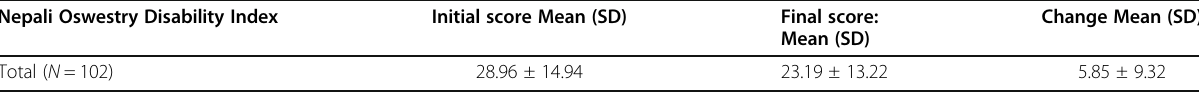
Table 2 NODI Score in initial and final assessment Nepali Oswestry Disability Index